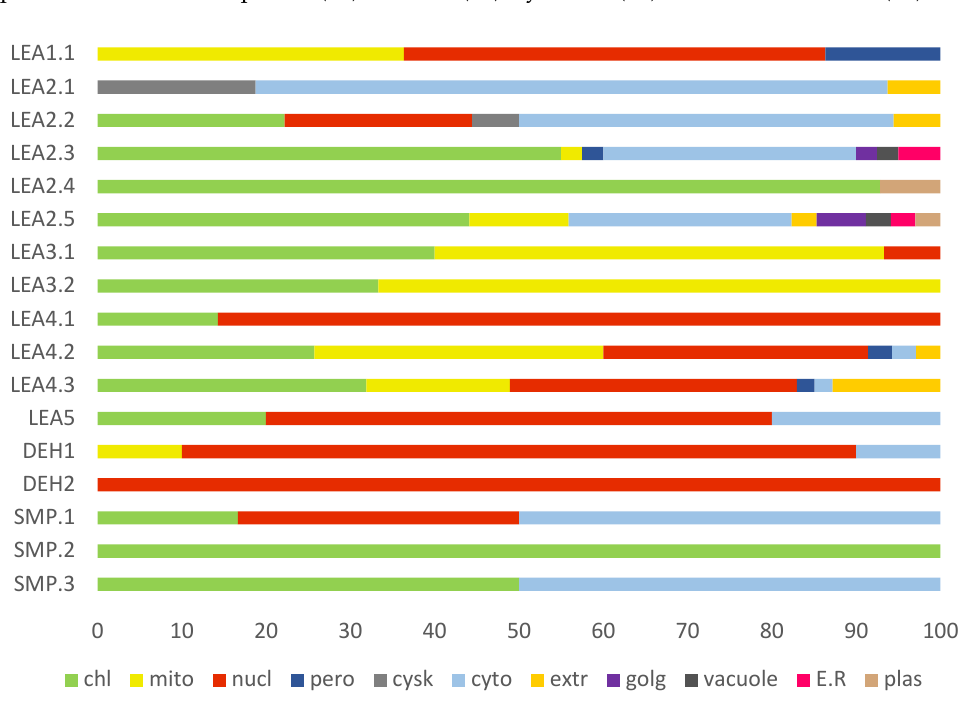
Figure 6. Repartition of the R. serbica LEAP-predicted subcellular distribution in each family (sub)group. Results are given in percentages. Chl, chloroplast; mito, mitochondrion; nucl, nucleus; pero, peroxisomes; cysk, cytoskeleton; cyto, cytosol; ext, extracellular space; golg, Golgi apparatus, E.R. endoplasmic reticulum; plas, plastids.